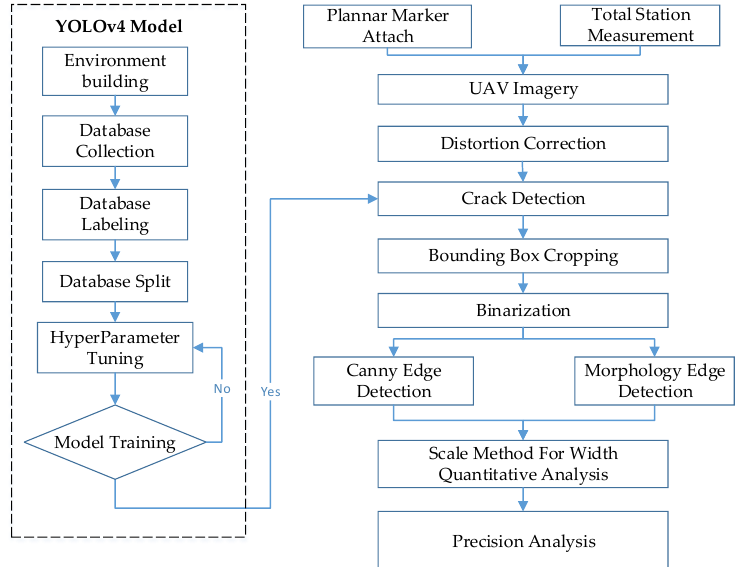
Figure 2. Research process.